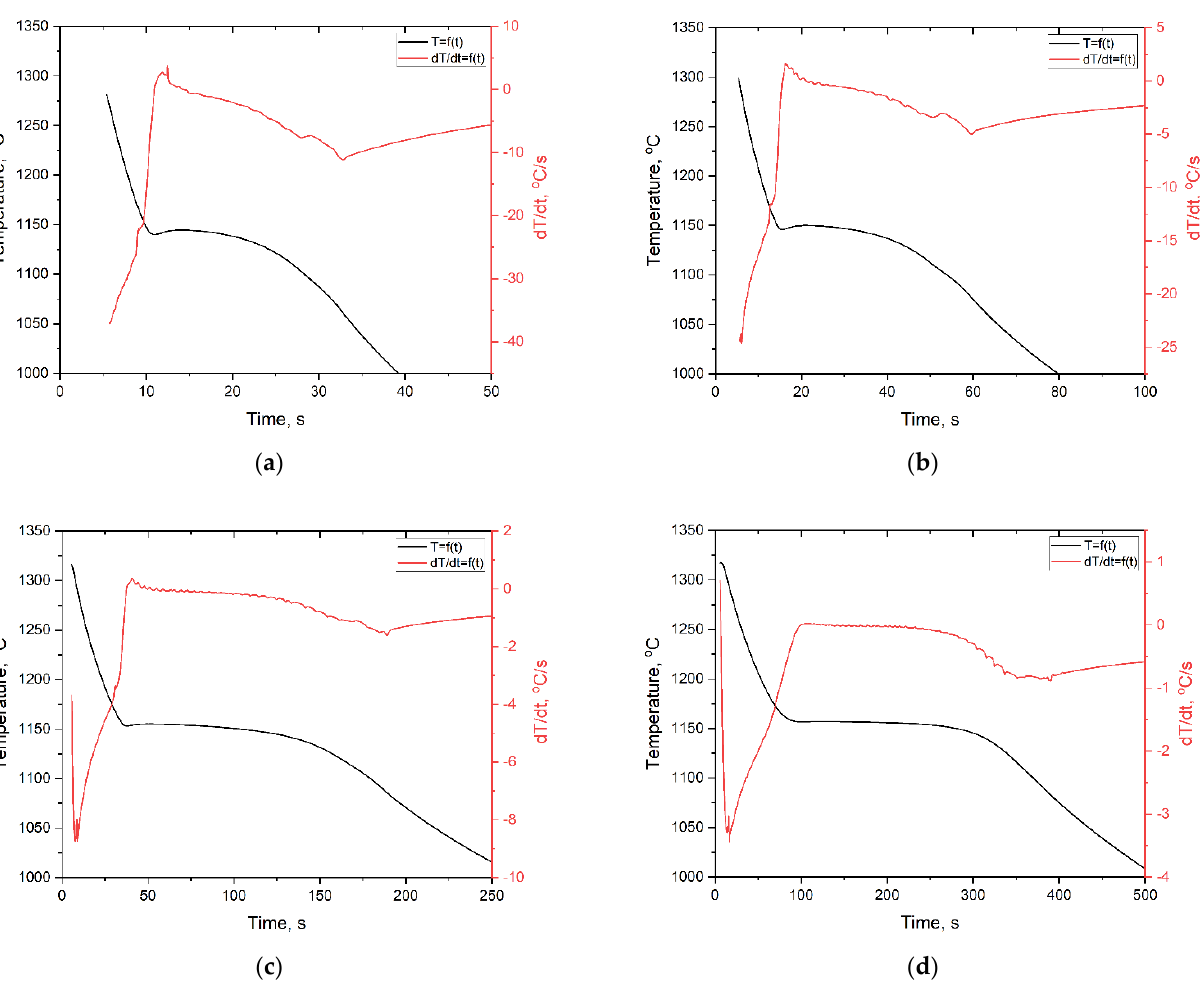
Figure 3. Simulated cooling curves and cooling rates of ductile iron in samples with different wall thicknesses: ( a ) 3 mm; ( b ) 5 mm; ( c ) 13 mm; ( d ) 25 mm.